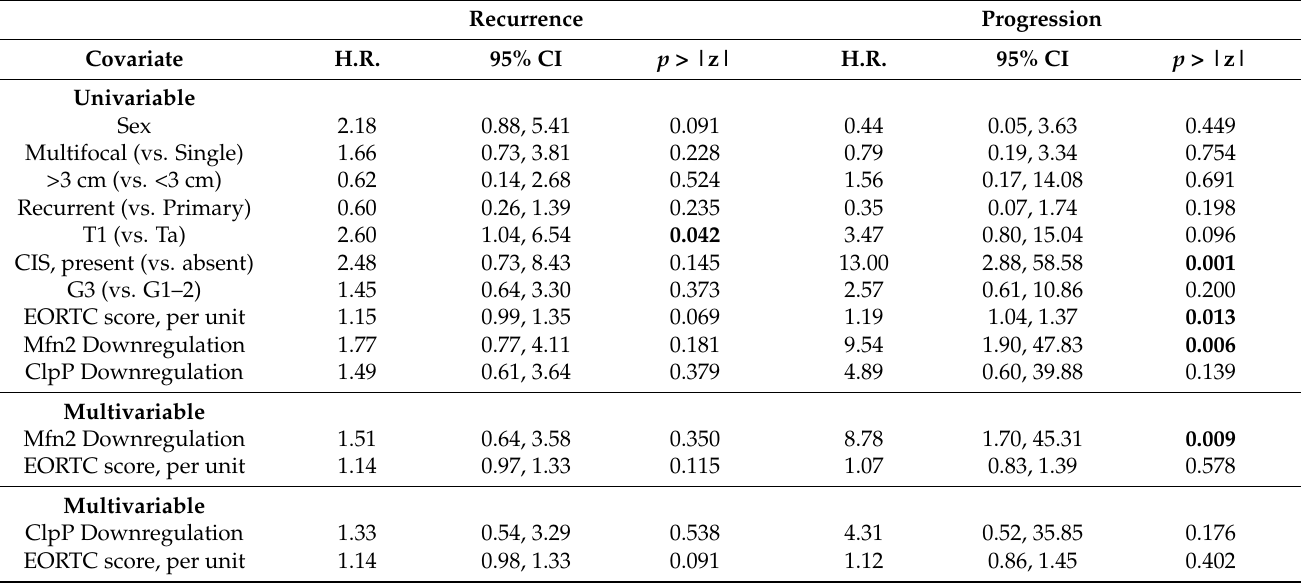
Table 3. Univariable and multivariable Cox regression analysis evaluating predictors of Recurrence and Progression in patients with NMIBC. EORTC scores for Recurrence and Progression were used accordingly. Recurrence Progression Covariate H.R. 95% CI p > |z| H.R. 95% CI p > |z|